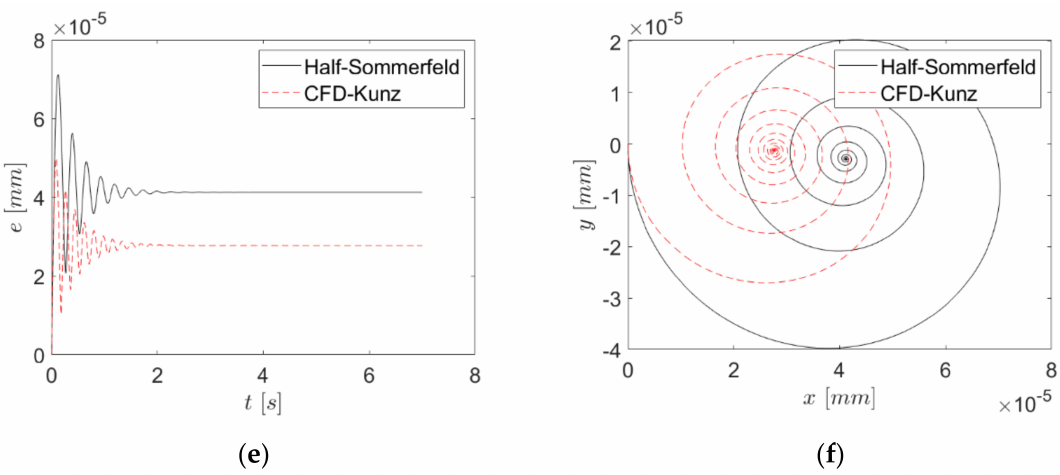
Figure 10. Trajectory of the journal ( b , d , f ) and damping ( a – c ) @3000 rad / s for di ff erent masses: top 2.5 kg–middle 5 kg–bottom 10 kg.